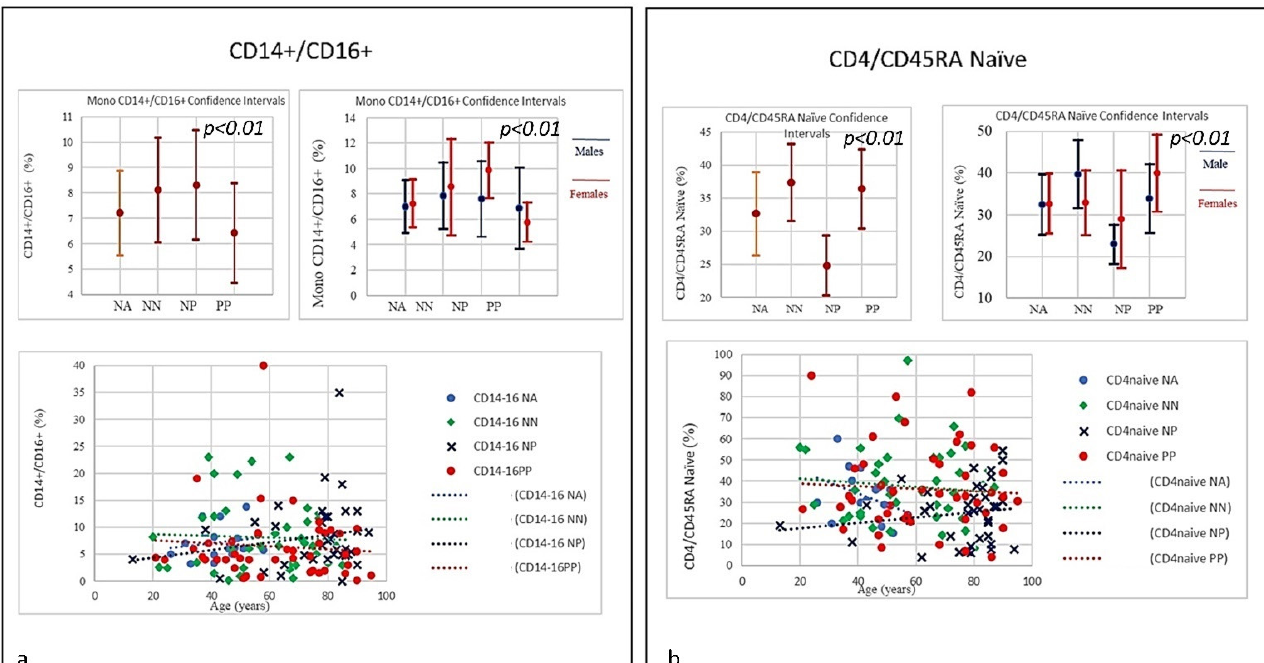
Figure 6. ( a ) Frequencies of CD14+CD16+ Monocyte lineages ratio in COVID-19 patients and controls (NP, NN, and NA). A significant increase in quantitative level of CD14+CD16+ monocytes correlated with age was observed. The increased level in the elderly may indicate they have undergone a senescence process and therefore they also secrete proinflammatory factors in response to low-intensity antigenic stimuli. A slight quantitative decrease in the PP group, which was not correlated with age, was also observed. However, the levels of both intermediate CD14+ and CD16+ as well as non-classical monocyte Neutrophils and NK cells were significantly elevated in NP patients. ( b ) Frequencies of CD+CD45RA Naïve level in COVID-19 patients and controls (NP, NN, and NA). The graphic shows a slight quantitative decrease in CD4 naïve in the PP group without correlation to age; however, there is a quantitative increase in CD4 naïve correlated to age in NP individuals. Notably, the starting level of CD4 naïve in the NP group was significantly lower than the one seen in PP group. Though the mechanism is yet to be clarified as, unlike age related changes in other T cell subsets, the stable level of T memory cells in peripheral blood may support CD4 naïve cells for long-term immunological memory, while their importance may increase together with ageing. However, higher morbidity and mortality following infections, particularly influenza, has been observed in elderly